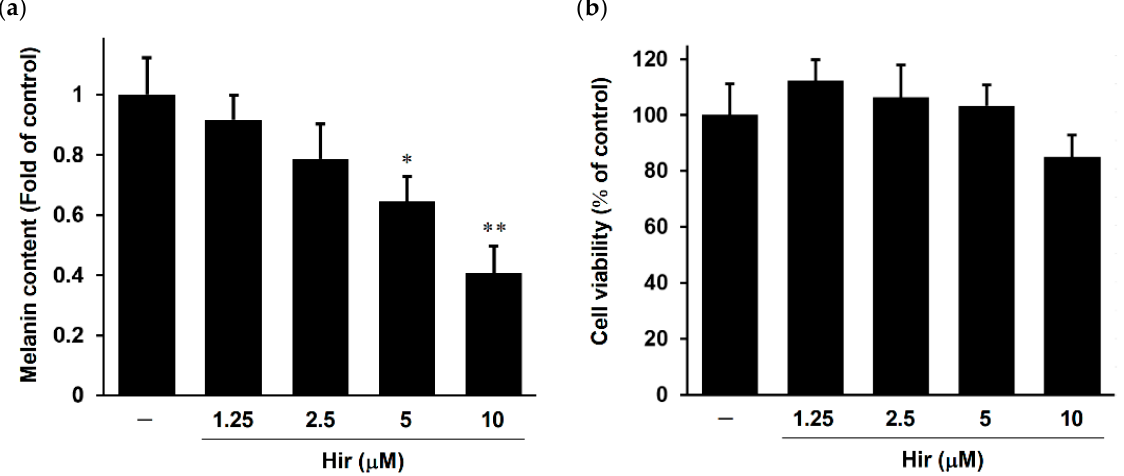
Figure 3. Effect of Hir on melanin biosynthesis and cell viability in HEMn-DP cells. The cells were treated with Hir at the indicated concentrations for 72 h. ( a ) Melanin content was determined as described in Materials and Methods. Values are the mean ± SD of three independent experiments. * p < 0.05 and ** p < 0.01 versus control. ( b ) Cell viability was determined as described in Materials and Methods. There were no significant differences between the control and experimental groups ( p > 0.05).